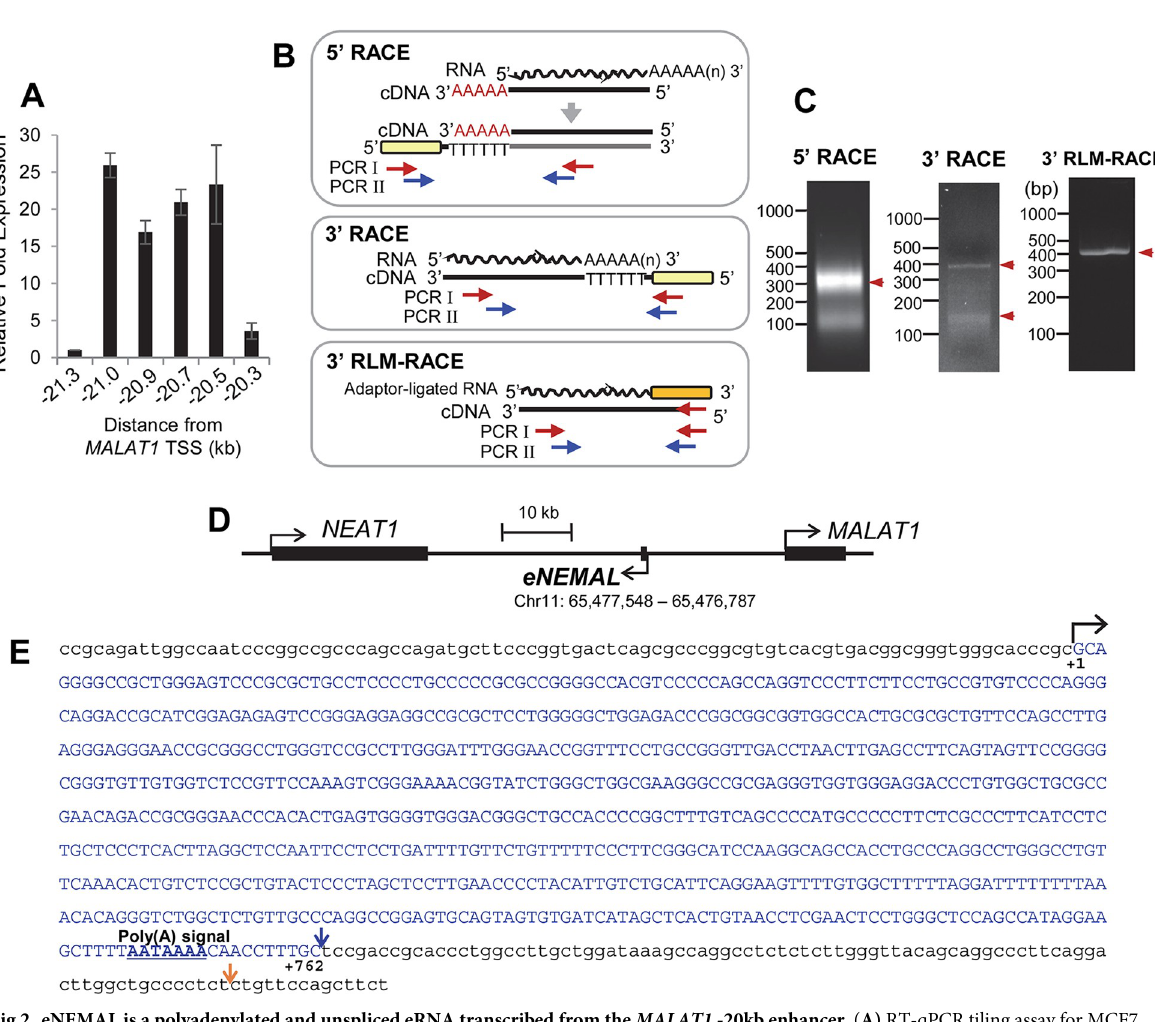
Fig 2. eNEMAL is a polyadenylated and unspliced eRNA transcribed from the MALAT1 -20kb enhancer. ( A) RT-qPCR tiling assay for MCF7 endogenous eRNA expression with coordinates relative to the MALAT1 transcription start site. Data shown as mean ± SD, n = 3. ( B ) Schematics of 5’ RACE, 3’ RACE, and RNA ligase-mediated 3’ RACE (3’ RLM-RACE), and the locations of the primers used. RNA used for RACE was isolated from MCF7 cells after 24 hours hypoxic exposure. Red arrows, primer sets used for the first PCR; Blue arrows, primer sets used for the second PCR; Yellow bar, adaptor; Orange bar, oligonucleotide ligated to RNA. In 5’RACE, AAAAA in red font indicates the DNA sequences added by the terminal transferase reaction. ( C ) Gel images of 5’ RACE, 3’ RACE and 3’ RLM-RACE products. Bands indicated with red arrowheads were cut and sequenced. ( D ) Genomic location of the identified eRNA, eNEMAL , relative to the MALAT1 and NEAT1 gene bodies. The position of the eNEMAL gene was determined using hg38 as reference genome. ( E ) Full sequence of the eNEMAL gene. Blue arrow downstream of the poly(A) signal indicates the poly(A)-tailed 3’ end of the eNEMAL transcript determined by 3’ RACE. Orange arrow indicates a non-poly(A)-tailed alternative 3’ end determined by 3’